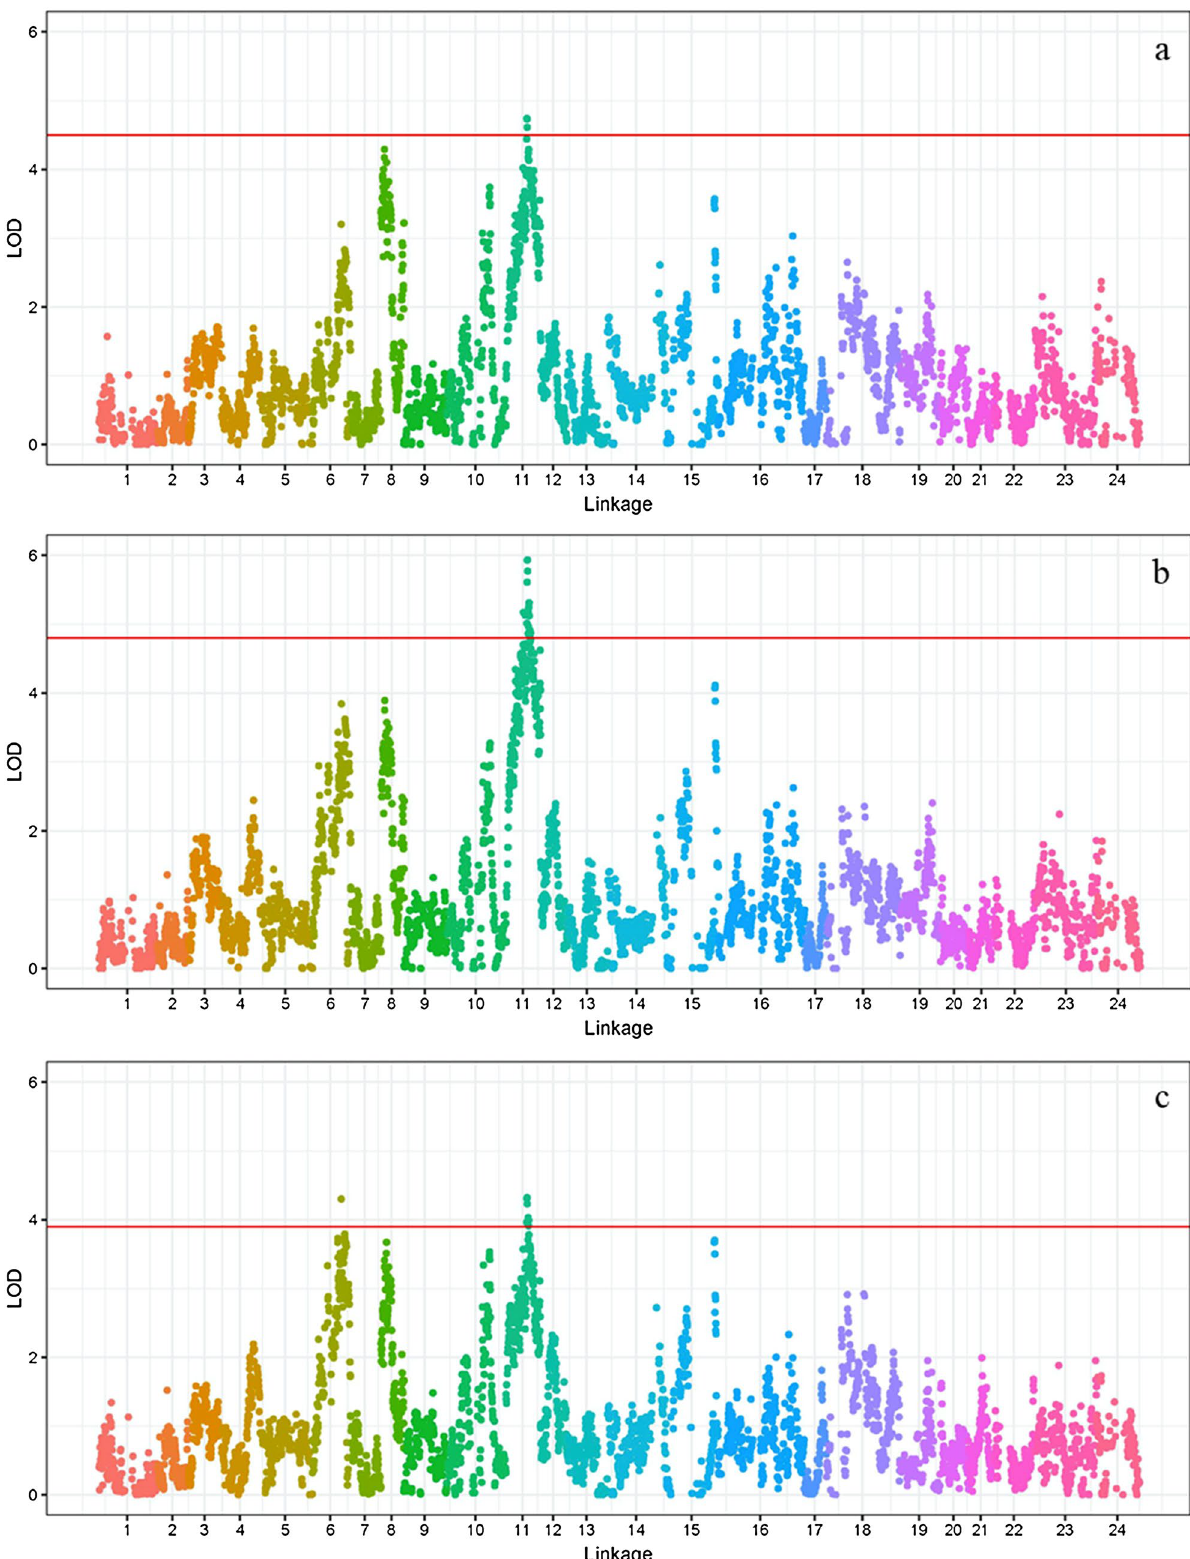
Figure 2. Total length ( a ), body length ( b ) and body weight ( c ) QTL mapping and association analysis in L. polyactis among all linkage groups. The x- and y-axes correspond respectively to relative position on the linkage groups and the LOD value. The red horizontal line represents a linkage group-wise logarithm of odds (LOD) significance threshold of 4.8 for total length, 4.5 for body length, and 3.9 for body